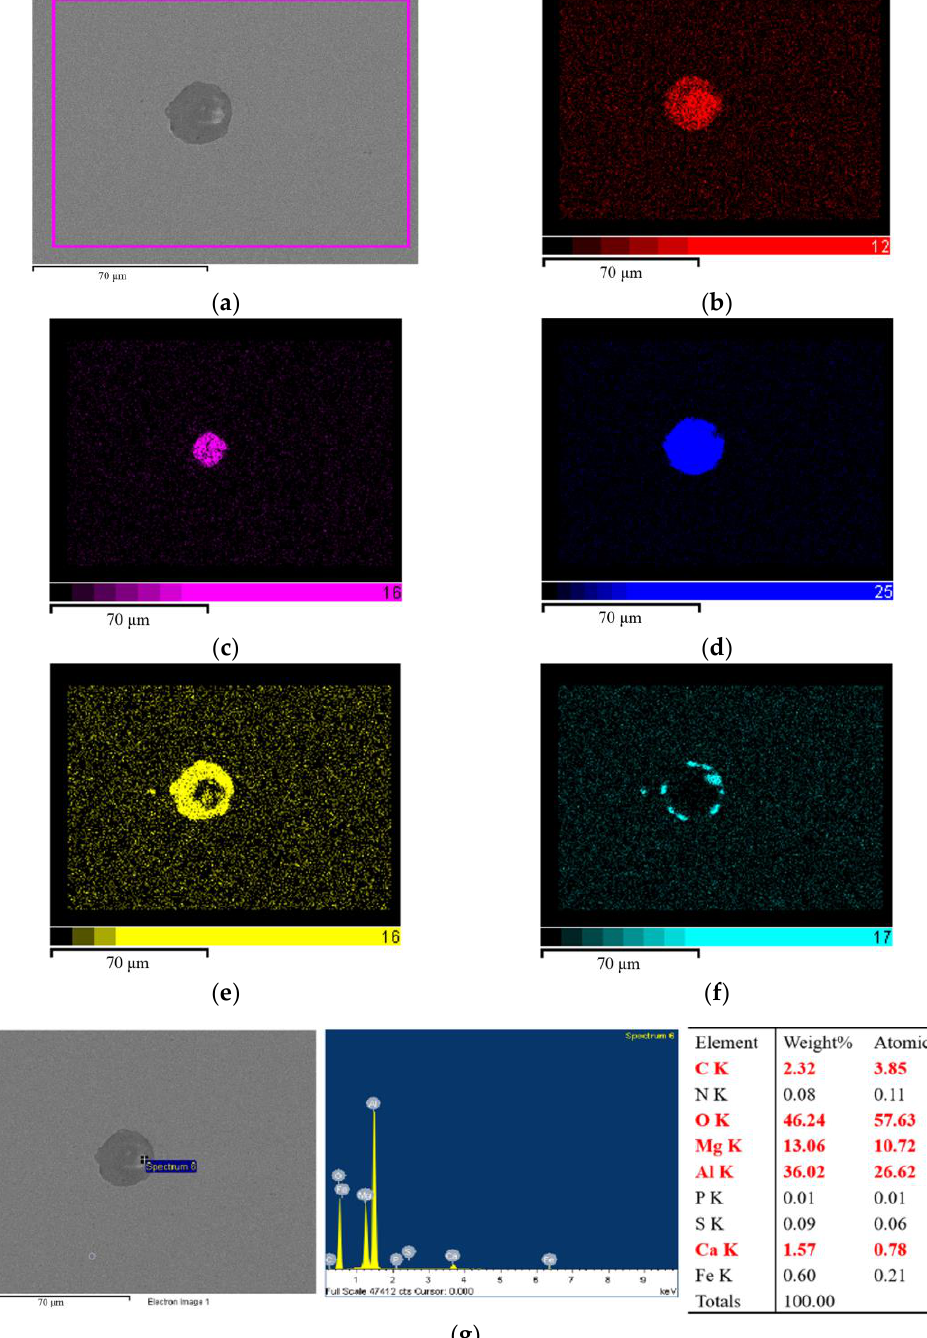
Figure 6. EDS results of typical Al 2 O 3 -MgO complex inclusion in experimental P91 steel; ( a ) SEM image; ( b ) O; ( c ) Mg mapping; ( d ) Al mapping; ( e ) Ca mapping; ( f ) S mapping; ( g ) Results of the EDS point scanning.